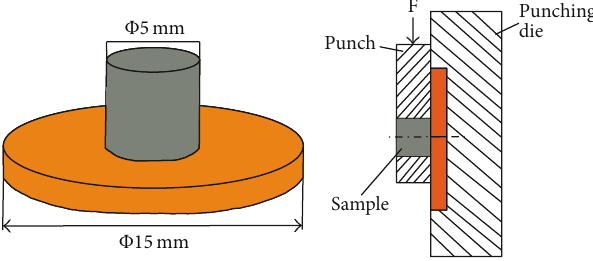
Figure 4: Test specimen for shear test and scheme of specimen in a jig during shear strength testing.